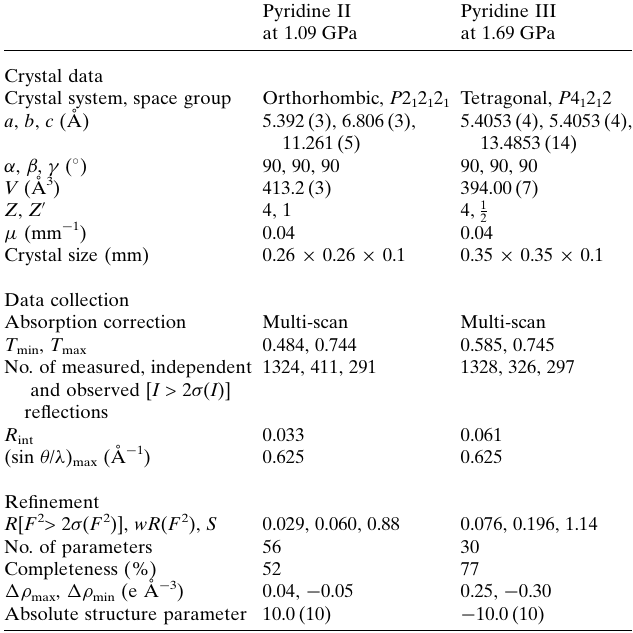
Table 1 Crystal and refinement data. For all structures: C 5 H 5 N, M r = 79.10. Experiments were carried out at 293 K with synchrotron radiation, (cid:3) = 0.49594 A˚ using a Perkin–Elmer a-Si detector. H atom parameters were constrained. Absolute structure parameters are inconclusive.